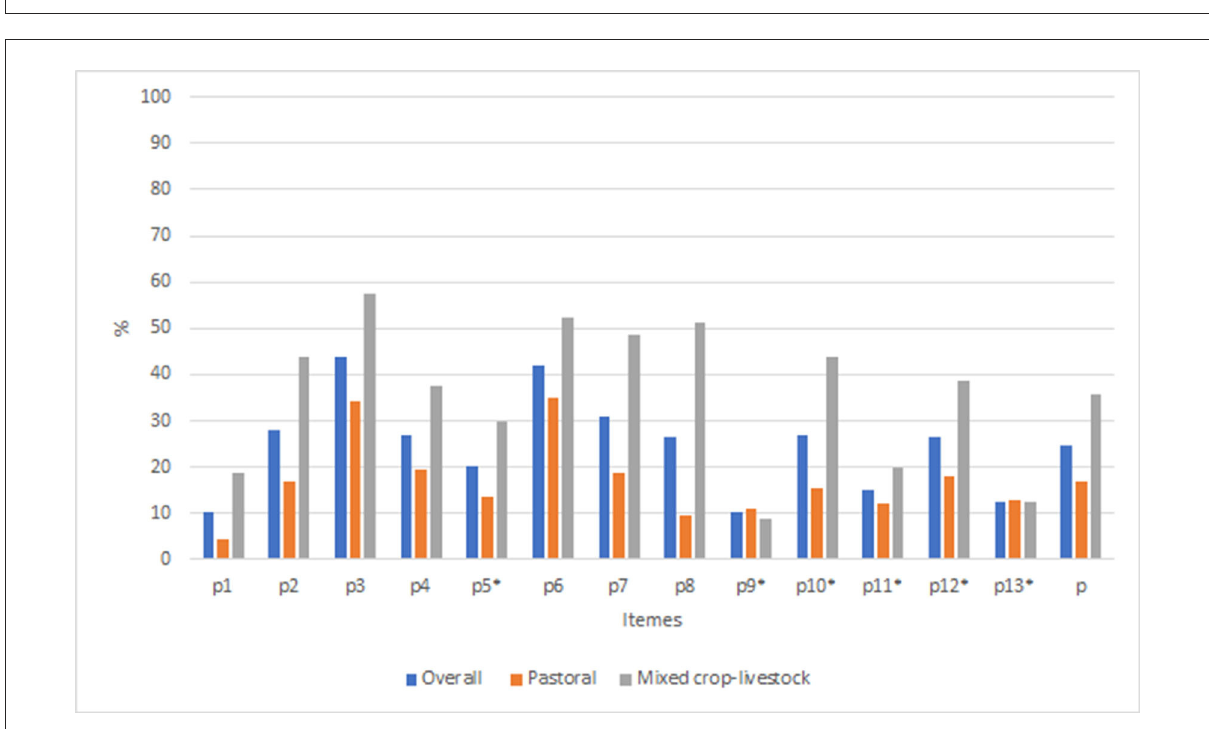
FIGURE7 Percent of correct responses for animal welfare practice items aggregated by production system in Ethiopia. Items with “*” indicate the scale were reversed.